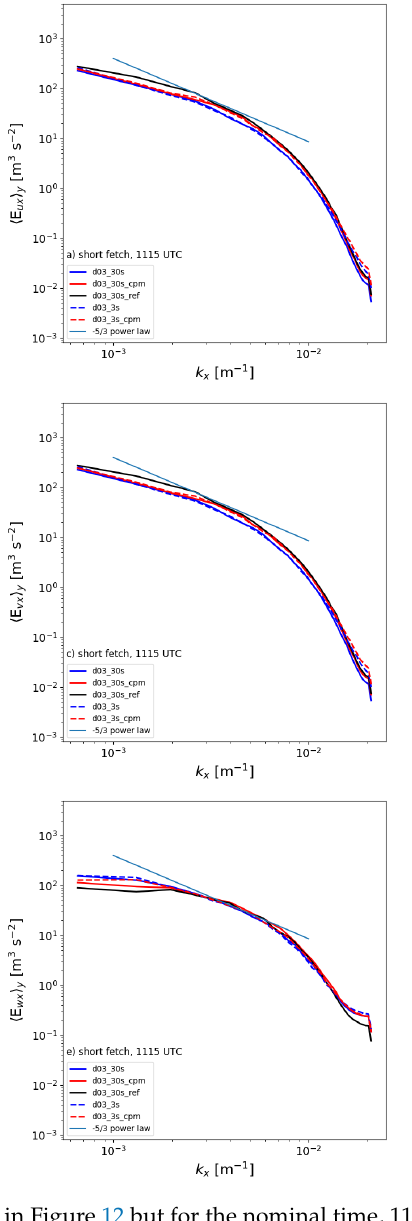
Figure 15. As in Figure 12 but for the nominal time, 1115 UTC, roughly concurrent with the 1113 radiosonde release on 20 May